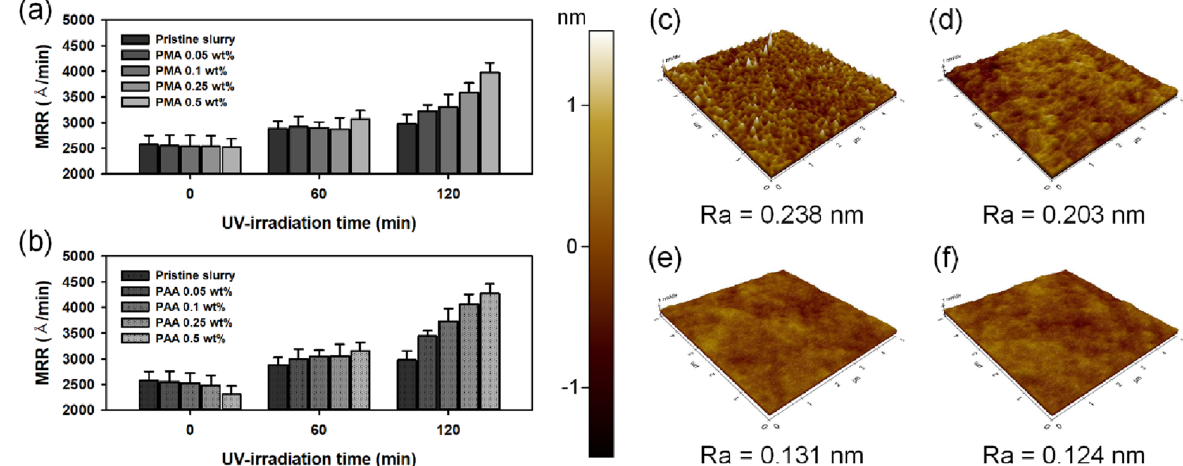
Figure 4. MRR of oxide wafer according to UV irradiation time with varying the concentration of polyacids; ( a ) PMA and ( b ) PAA and following averaged surface roughness (R a ) of SiO 2 wafer; ( c ) before polished, ( d ) polished by pristine ceria slurry, ( e ) polished by UV irradiated slurry with 0.5 wt.% of PAA for 1 h and ( f ) for 2